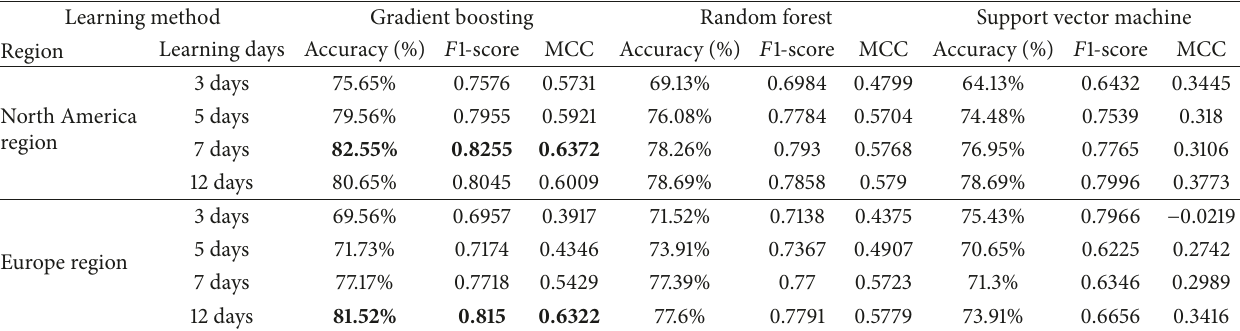
Table 5: Experimental results of predicted WoW token prices